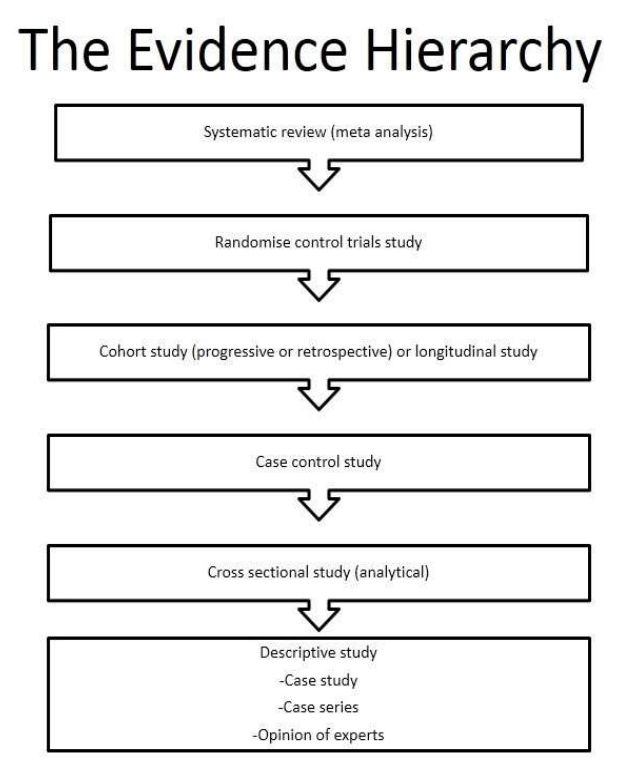
Figure 1. Studies showing the hierarchy of research evidence-based health care [6,7]. The SANDP vision for 2030 [1] highlights key recommendations for reducing the prevalence of NCDs by 28% in 2030, which are all mirrored in the World Heart